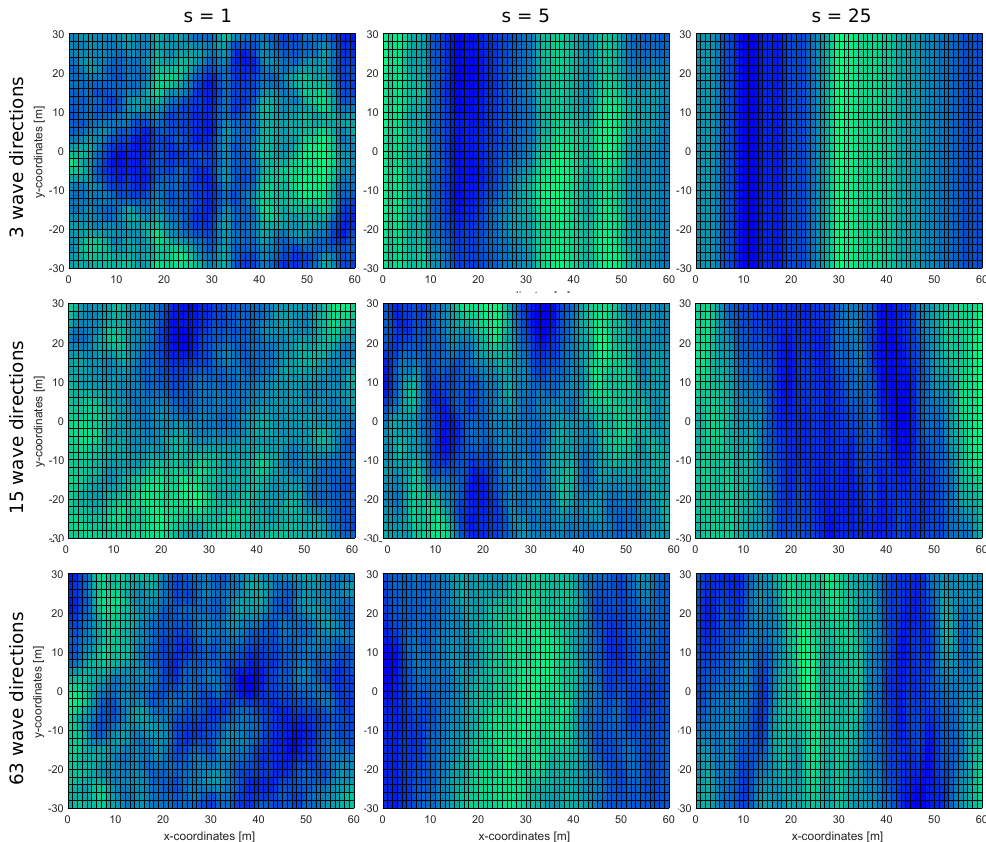
Figure 6. Surface elevations corresponding to the surfaces in Figures 3–5, but here shown in two dimensions and over a larger ocean surface. The crests/throughs are shown in green/blue color according to the three-dimensional plots in Figures 3–5. The spreading parameter increases with the columns, with s = 1 in the left column, s = 5 in the middle and s = 25 in the right column. The number of wave directions increases with the rows, with three wave directions in the top row, 15 in the middle and 63 wave directions in the bottom